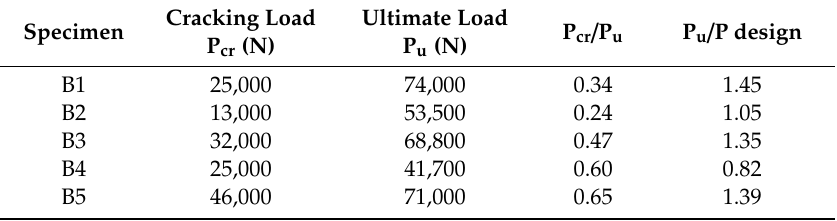
Table 8. The cracking and ultimate load of series I and II